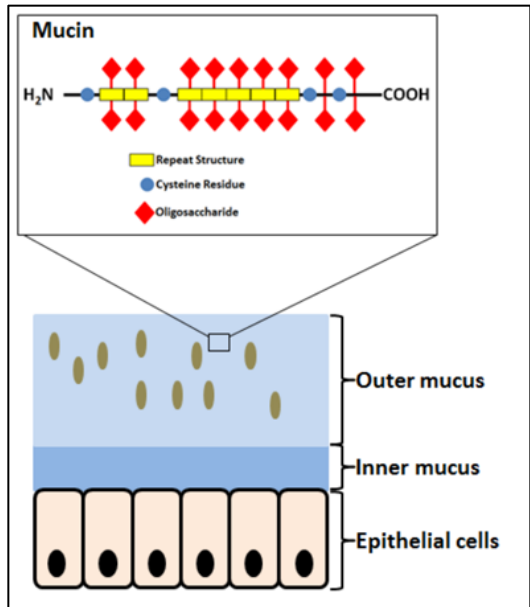
Figure 1. Schematics of the mucosa covering the gastrointestinal tract and the structure of mucin, the glycoprotein component of the mucus layer. Brown ovals illustrate bacteria. Modified from Reference [17].